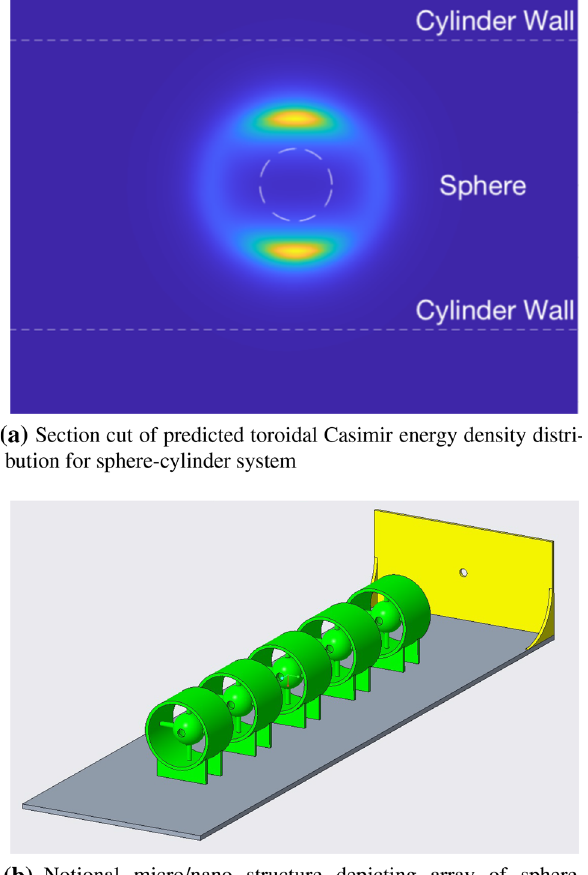
Fig. 10 The top panel depicts a section cut of predicted toroidal Casimir energy density distribution for sphere-cylinder system com- prised of a 1 µ m diameter sphere suspended in the middle of a 4 µ m diameter cylinder. The approach was implemented using Open MPI- enabled c-code and the analysis was run on 660 2.40 GHz Intel Skylake CPUs. The model grid was a 100 × 100 grid with a 2000 unit-loop ensemble. The bottom panel depicts a notional experimental setup that comprises an array of sphere-cylinder constructions arranged such that a pulse of electrons or photons may be routed through the test device in an attempt to measure a change in transit time for an equivalent pulse routed through free